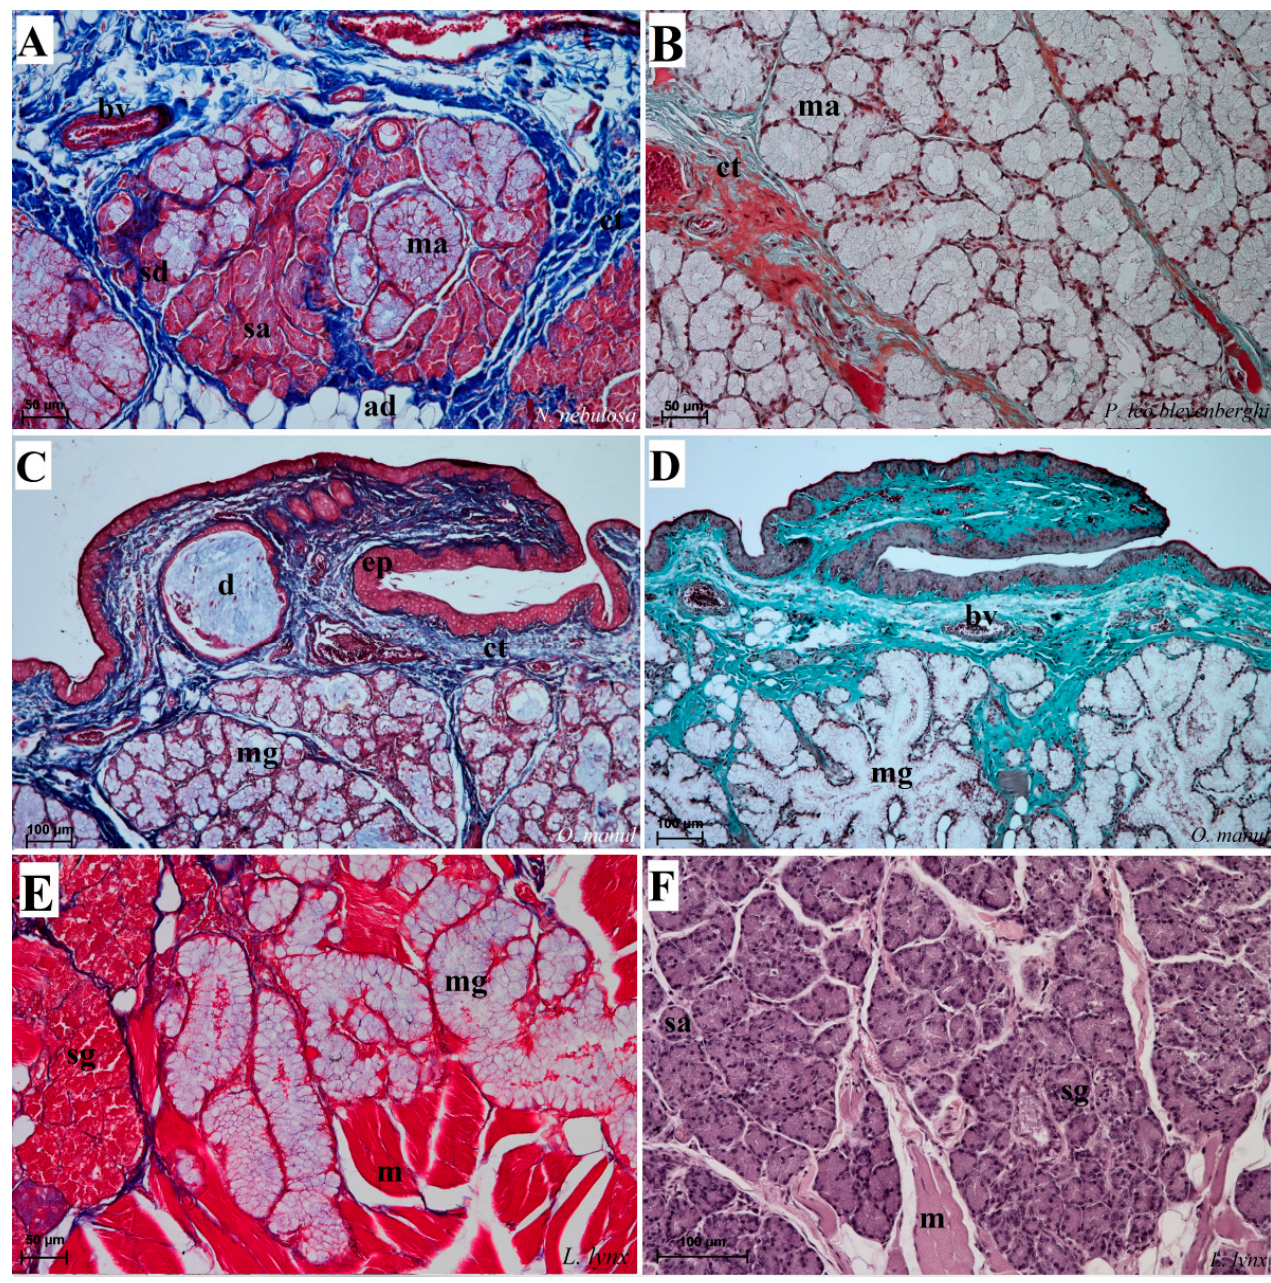
Figure 12. Histological pictures of the lingual glands of the root of the tongue in four species of undomesticated Felidae: N. nebulosa ( A ), P. leo bleyenberghi ( B ), O. manul ( C , D ) and L. lynx ( E , F ). ( A ) Mucoserous glands with presence of mucous and serous acini. Some mucous acini with serous demilunes are visible. ( B ) Serous glands beneath vallate papilla. ( C ) Longitudinal section of the mechanical lingual papilla and cross-section of the duct of the lingual glands as well as mucoserous glands with the dominance of mucous acini. ( D ) Mucoserous glands with dominance of mucous acini. ( E ) Mucoserous glands of the root of the tongue. ( F ) Serous glands in the tongue root. Azan trichrome staining ( A , C , E ); Masson–Goldner trichrome ( B , D ); H&E staining ( E ). Bar = 100 µm (C,D,F); bar = 50 µm (A,B,E). Abbreviations: ad — adipocytes, bv — blood vessel, ep — epithelium, ct — connective tissue, m—muscle fibers, ma—mucous acini, mg—mucoserous glands with dominant mucous acini (ma), sa — serous acini, sg—serous glands, sd—serous demilunes.